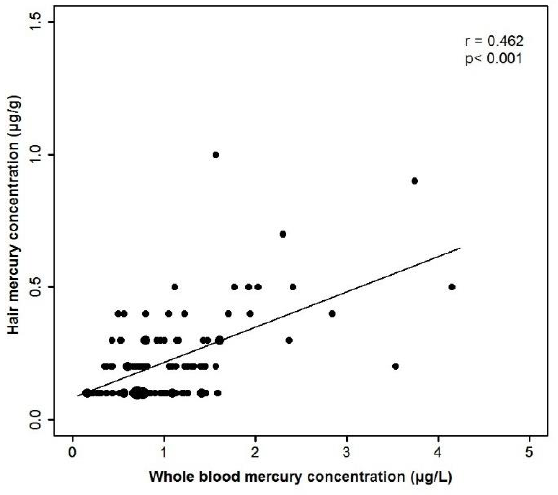
Figure 1. Correlation between whole blood mercury concentration and hair mercury content.